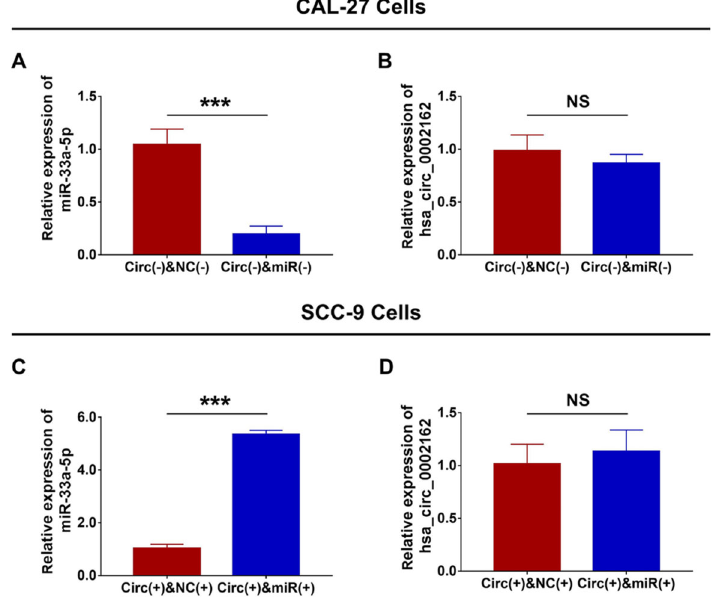
Figure 6. Comparison of A , miR-33a-5p and B , hsa_circ_0002162 expressions between the Circ( – ) & miR( – ) group and the Circ( – ) & NC( – ) group. Comparison of C , miR-33a-5p and D , hsa_circ_0002162 expressions between the Circ( + ) & miR( + ) group and the Circ( + ) & NC( + ) group. Data are reported as means ± SD. ***P o 0.001 ( t -test). NS: not signi fi cant; miR: microRNA; Circ: circRNA; NC: negative